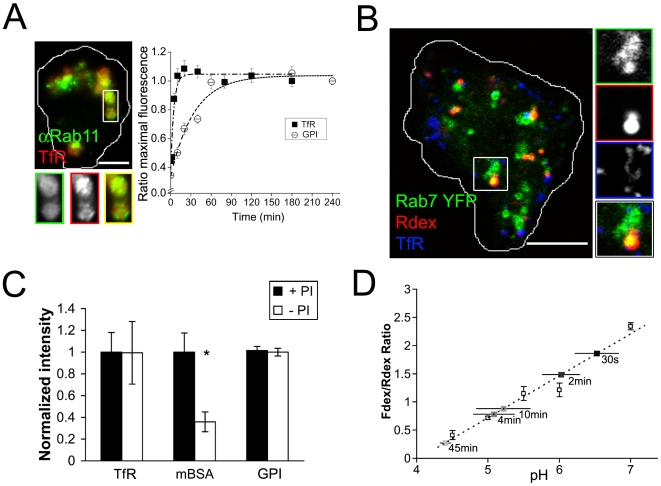
Characteristics of endosomal progression in S2R+ cells.(A) A568Tf (TfR) was pulsed for 15 min and cells were processed for immunocytochemistry with anti-Rab11 (αRab11), and subsequently imaged at high resolution. Plot shows kinetics of Tf and αGFP uptake in S2R+ cells transfected with the either the human TfR or GFP-GPI in an approach to steady state assay (see Materials and Methods). Each data point represents the mean±s.e.m. of a replicate experiment from at least 200 cells/replicate. Points have been fit to y = 0.381+0.666(1 – e-0.216t), R2 = 0.922 for TfR and y = 0.339+0.698(1 - e-0.029t), R2 = 0.966 for GFP GPI. (B) TMR-dextran was co-pulsed with A647Tf for 15 min in cells expressing Rab7 YFP, and cells were imaged with a spinning disk confocal. A single (median) plane from a stack is shown. (C) Cells expressing corresponding receptors were pulsed with TfR, mBSA or αGFP for 2 hrs and then the probes were chased in complete medium for an additional 2 hrs in the presence (+PI) or absence (-PI) of protease inhibitors. The integrated intensity of each probe in cells was then quantified and normalized to controls. Values are represented as mean±s.e.m. from at least 100 cells per treatment in 2 independent experiments. Asterix denote P<0.05 by Student's t-test. (D) Endosomal pH measurements. S2R+ cells were pulsed for 30 min with Fdex and Rdex, washed and mildly fixed, and subsequently equilibriated with a range of different buffer pHs to obtain a linear calibration of the ratio of Fdex/Rdex fluorescence against pH (dotted line through empty circles; R2>0.95). To label different populations of endosomes, S2R+ cells were either pulsed for 30 s with Fdex and Rdex or pulsed and then chased for 2 min, 4 min, 10 min and 45 min (shown on the graph as squares filled in descending grayscale). The ratio of Fdex/Rdex intensities was measured and compared to equilibriated values to obtain pH values. 30 s fluid endosomes were mildly acidic with a pH of 6.5±0.3 (mean±s.e.m. of 2 independent experiments, >30 cells for each time point) whereas the pH of more mature fluid endosomes was progressively more acidic, with 45 min endosomes having a pH of 4.4±0.1, close to values reported for lysosomes. Bars in A = 2.5 µm, B = 5 µm, insets magnified 2x.